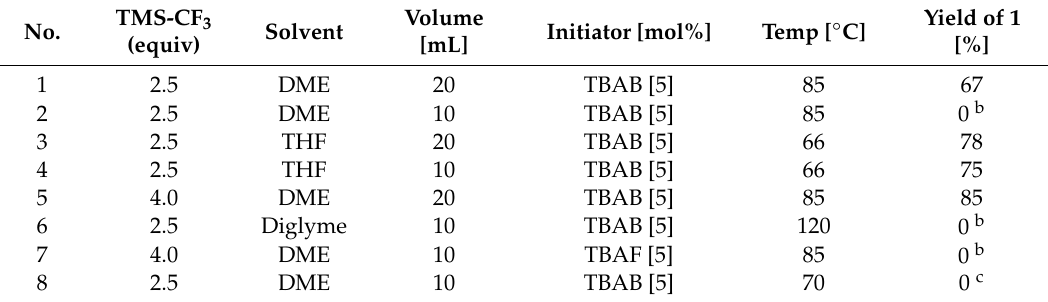
Table 2. Optimization of the reaction conditions using TMS-CF 3 as the source of carbene a